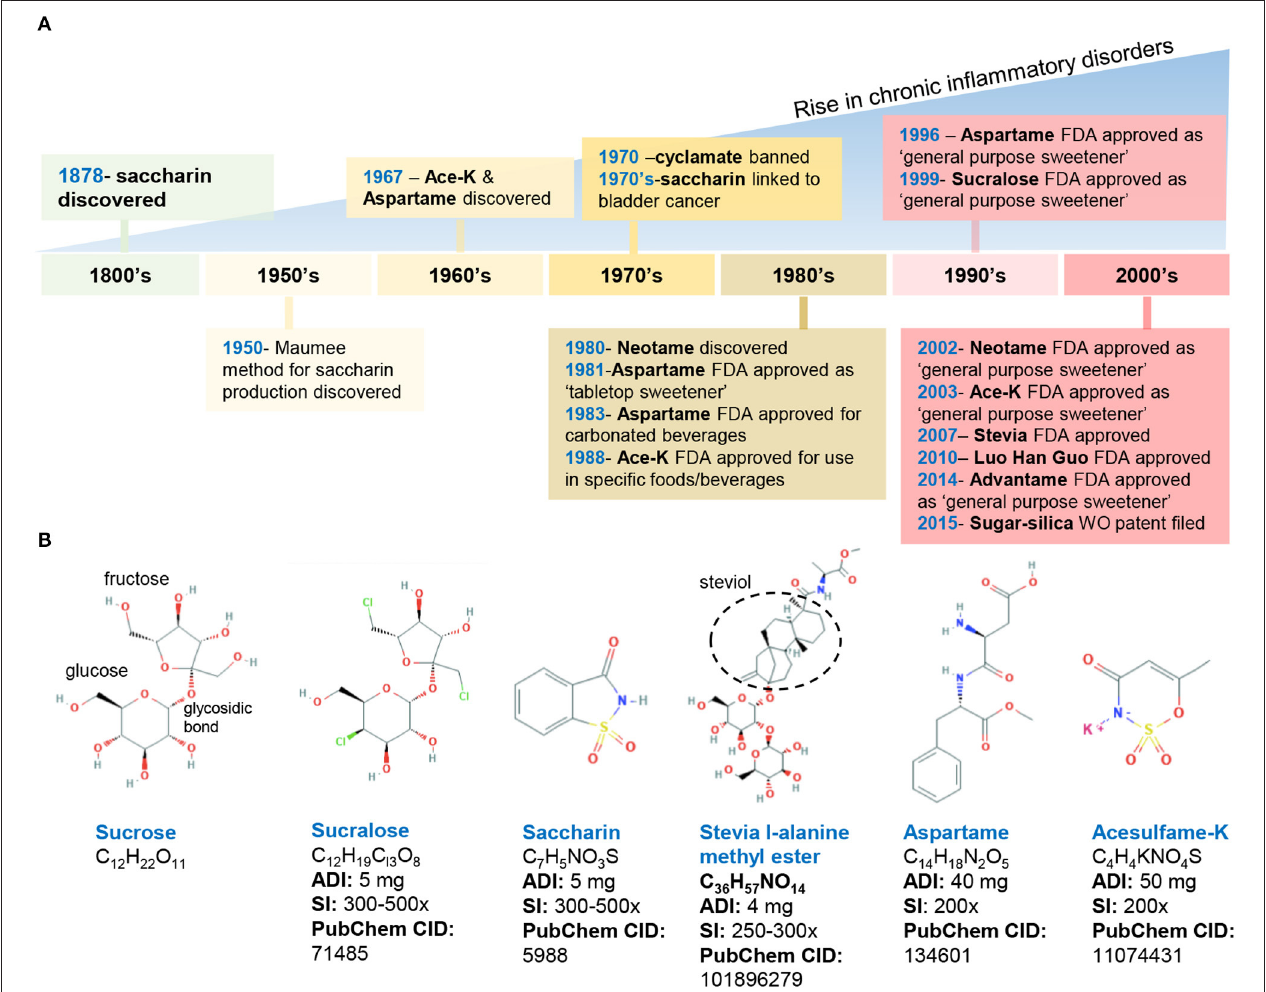
FIGURE 1 | Historical timeline of artificial sweeteners approved by the FDA for use in the food industry. (A) timeline of FDA approved AS. (B) Chemical structure and characteristics of the commonly used AS. ADI, acceptable daily intake; SI, sweetness intensity (relative to sucrose); WO, world (2015/159156 A2). Images, public domain